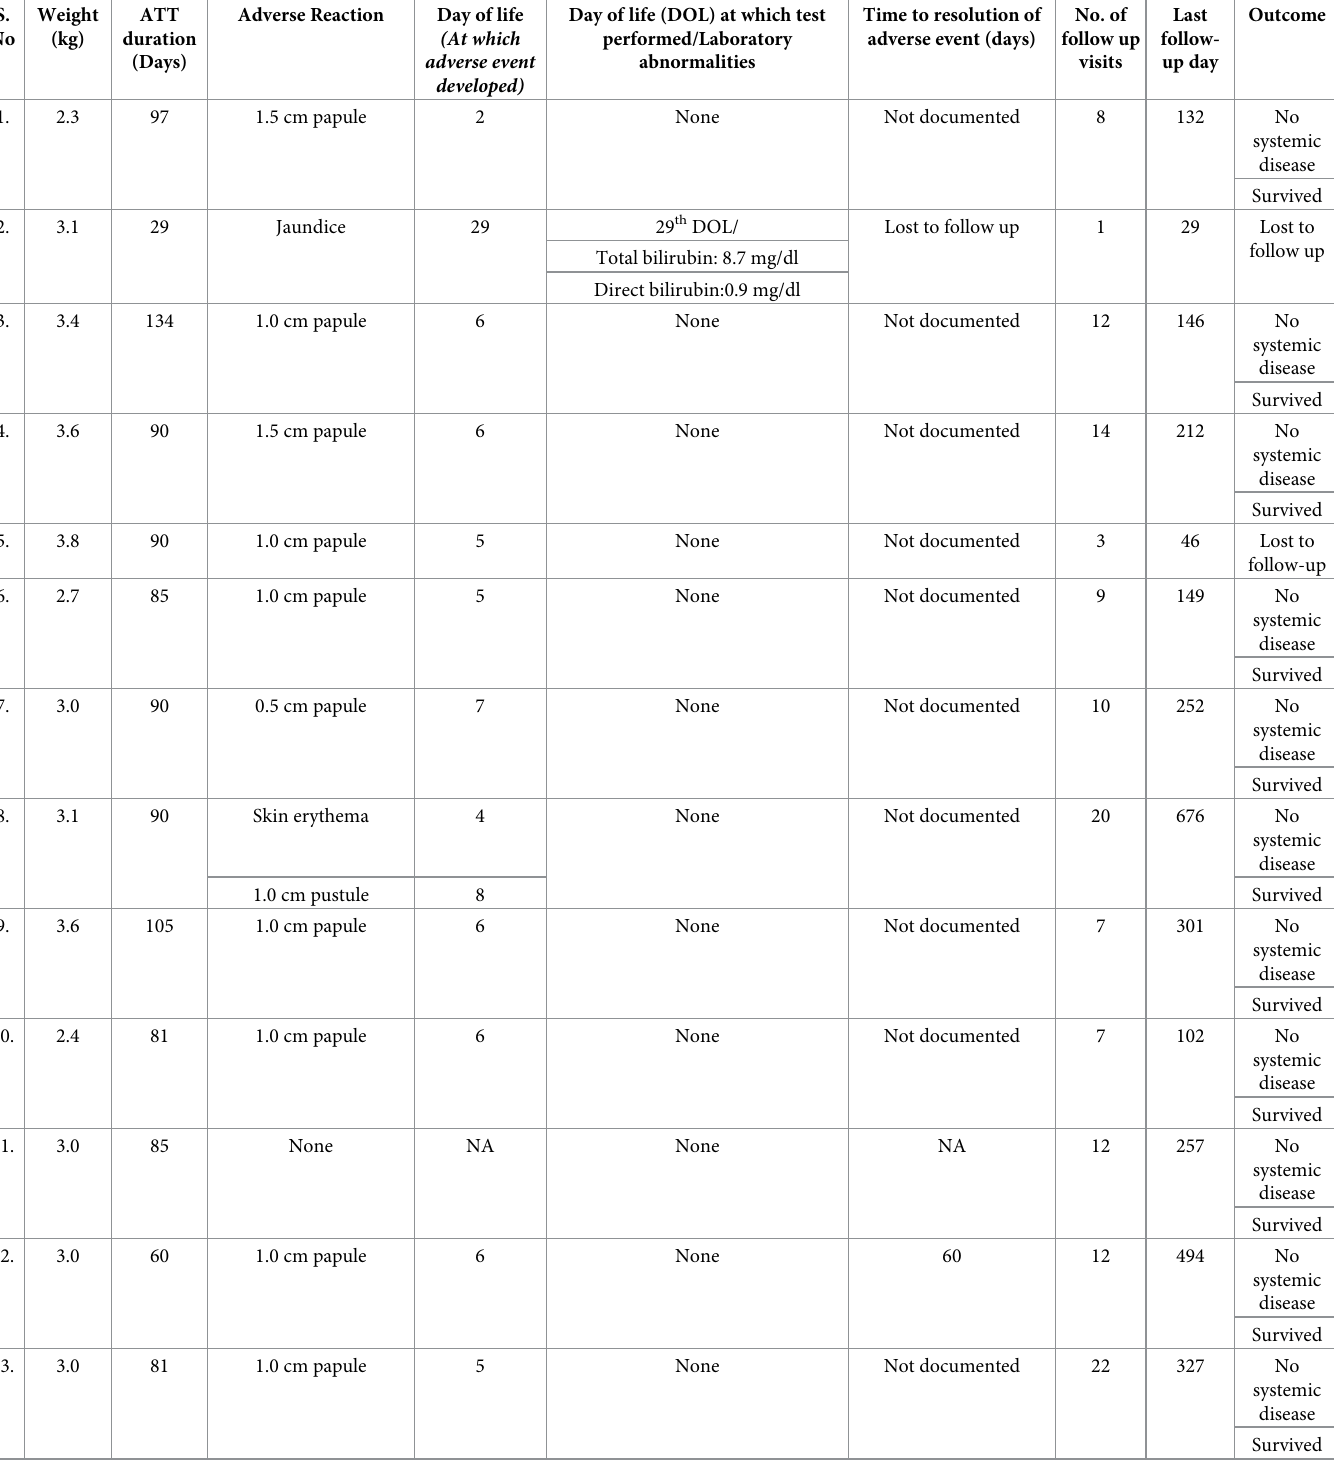
Table 3. Clinical profile and laboratory characteristics of newborns received high dose BCG vaccine in a tertiary care hospital,